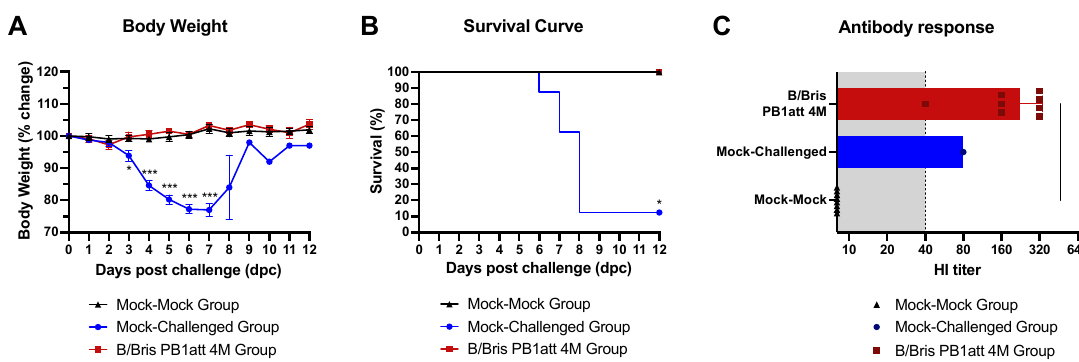
Figure 4. Protective efficacy of B/Bris PB1att 4M vaccine against homologous challenge. Vaccinated (B/Bris PB1att 4M) or unvaccinated (mock-challenged) DBA/2J mice were challenged with the homologous lethal strain B/Bris PB2-F406Y 21 days post-boost. A non-vaccinated, non-challenged control group was included (mock-mock). ( A ) Percentage body weight change and ( B ) survival rate were evaluated daily for 12 days post-challenge. ( C ) The serum antibody response against the homologous (B/Bris wt) virus was measured by HI assay at 14 days post-challenge (dpc). Shaded area indicates cutoff for HI titers considered to be predictive of protection. Weight loss data were compared using two-way ANOVA corrected for multiple comparisons using Holm–Sidak’s test. Survival curves were compared using log-rank Mantel–Cox curve comparison. Significant differences, compared with the mock-challenged group, are indicated. * p < 0.05, *** p < 0.001. Plotted data represent means ± standard errors.